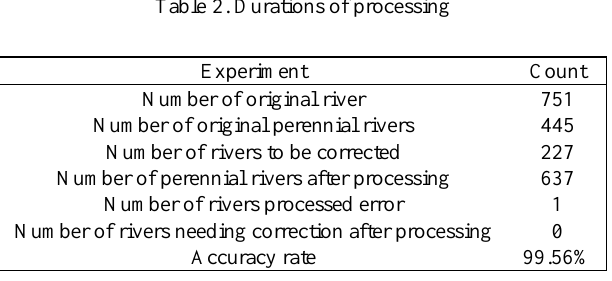
Table 3. Data after correction